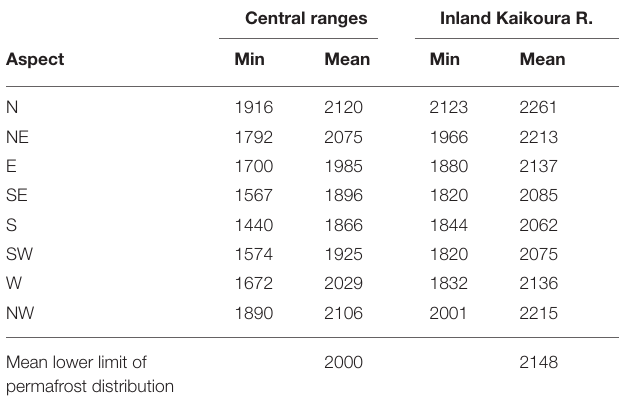
TABLE 2 | Elevation summary [m asl] for locations with permafrost probability between 0.6 and 0.7 according to aspect classes as well as averaged over all orientations, representing the estimated lower limit of the potential permafrost extent in the central Southern Alps and the Inland Kaikoura Range. Inland Kaikoura